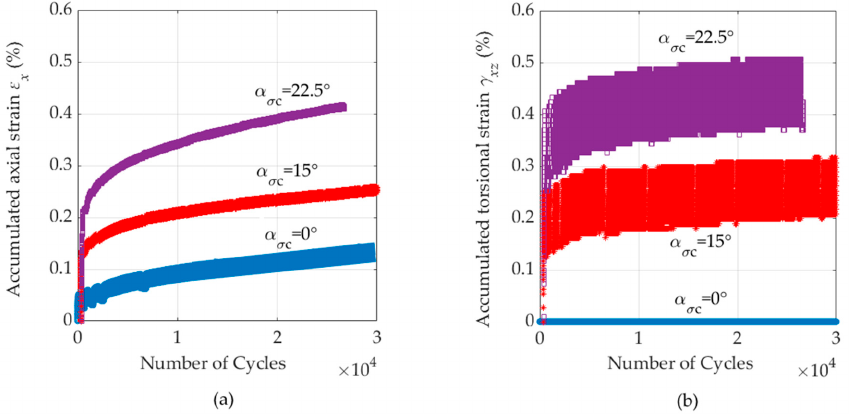
Figure 12. Strain accumulation curves in terms of ( a ) axial strain and ( b ) torsional strain with varying cyclic directions.